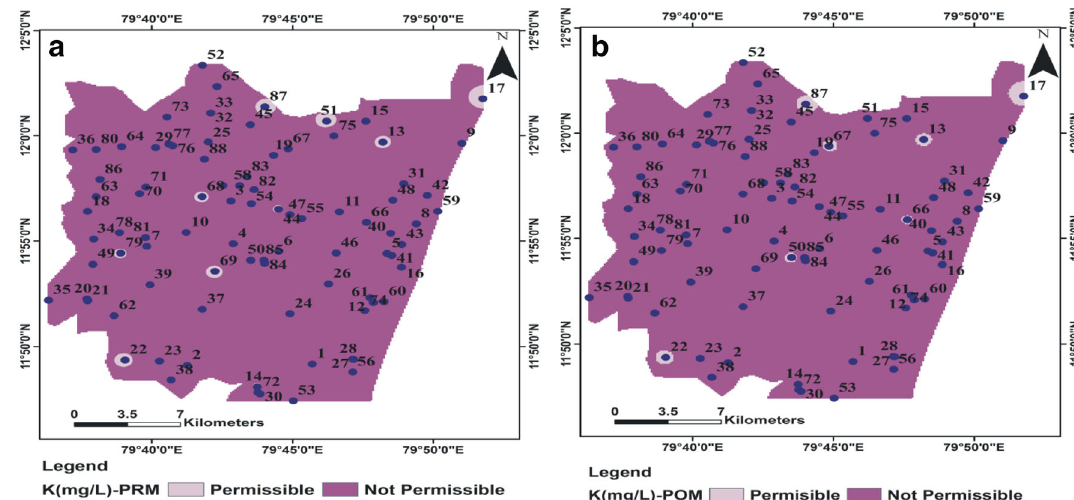
Fig. 7 a , b Spatial distribution map of K (pre- and post-monsoon)